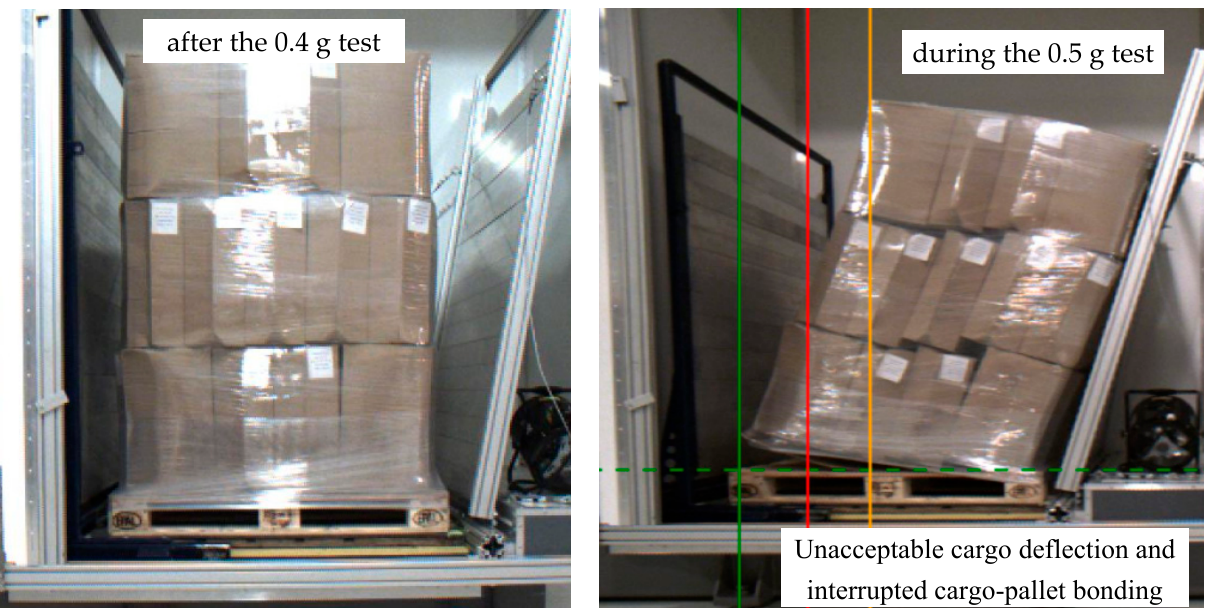
Figure 10. Cargo stability test at specified acceleration of 0.4 g and 0.5 g.